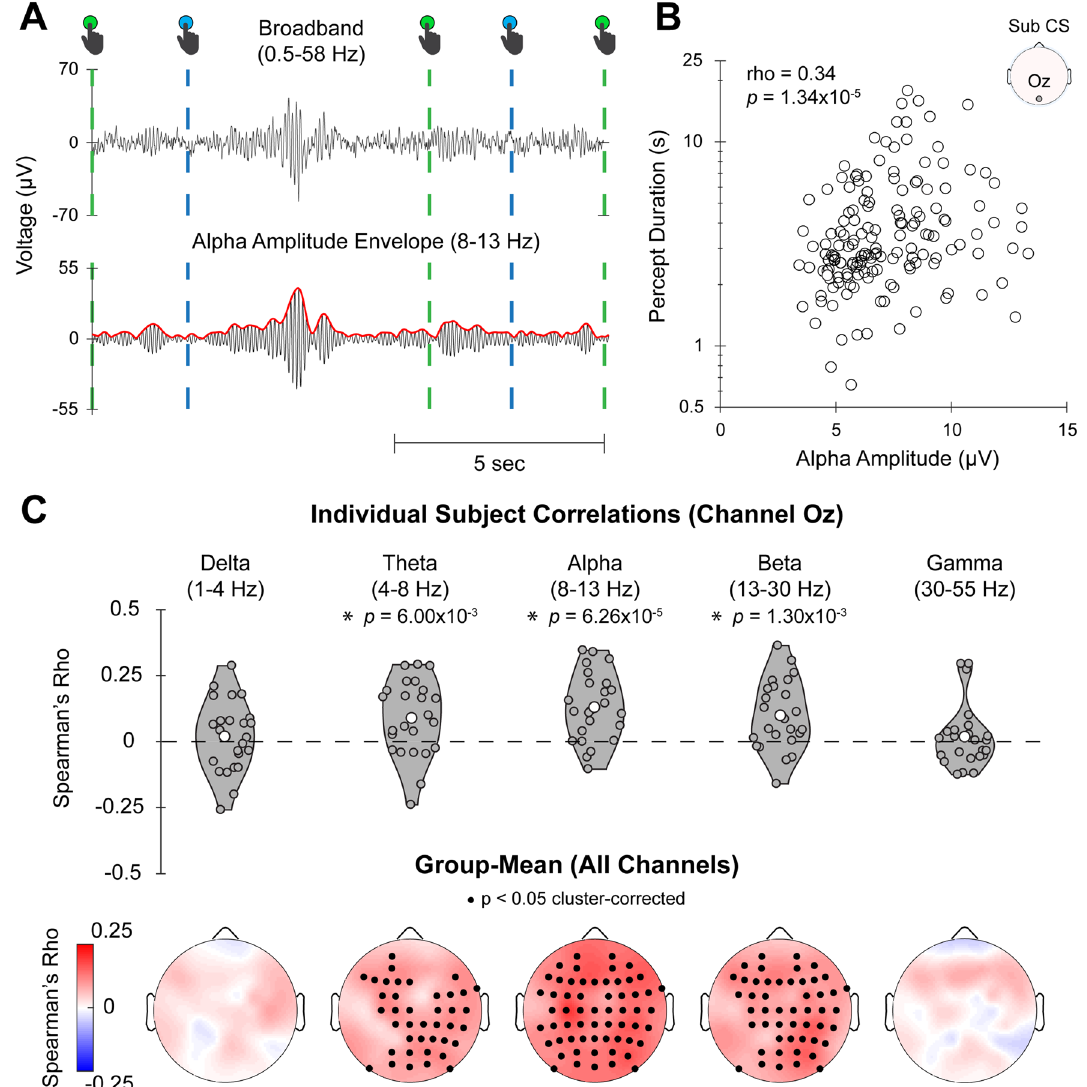
Figure 3. Longer percept durations correlate with higher alpha and beta amplitudes. ( A ) An example EEG recording over 12 s of continuously viewing the Necker cube. The signal was bandpass filtered in the alpha band (8–13 Hz) (black curve) and then Hilbert-transformed (red curve is the amplitude envelope). Dashed lines indicate times of button presses and color indicates whether the green-fronted cube or blue-fronted cube is reported as perceived. ( B ) Scatter plot shows all percept durations ( n = 157) and the mean alpha amplitude during each percept (from channel Oz) for a single subject, from cube trials in the continuous-viewing condition. ( C ) Top : Violin plots show the distribution of Spearman rho values (calculated between EEG amplitude and percept duration over all percepts) across subjects for channel Oz (* p < 0.05, one-sample t-test on Fisher-z-transformed rho values, df = 23). Bottom : Topo-plots show group-averaged Spearman rho values. Black dots indicate channels with significant Spearman correlation (one-sample t-test on Fisher-z-transformed rho values, N = 24, corrected using cluster-based permutation test and thresholded at p < 0.05, two-tailed). Data for cube trials are shown here (see Fig. S3 for face-vase